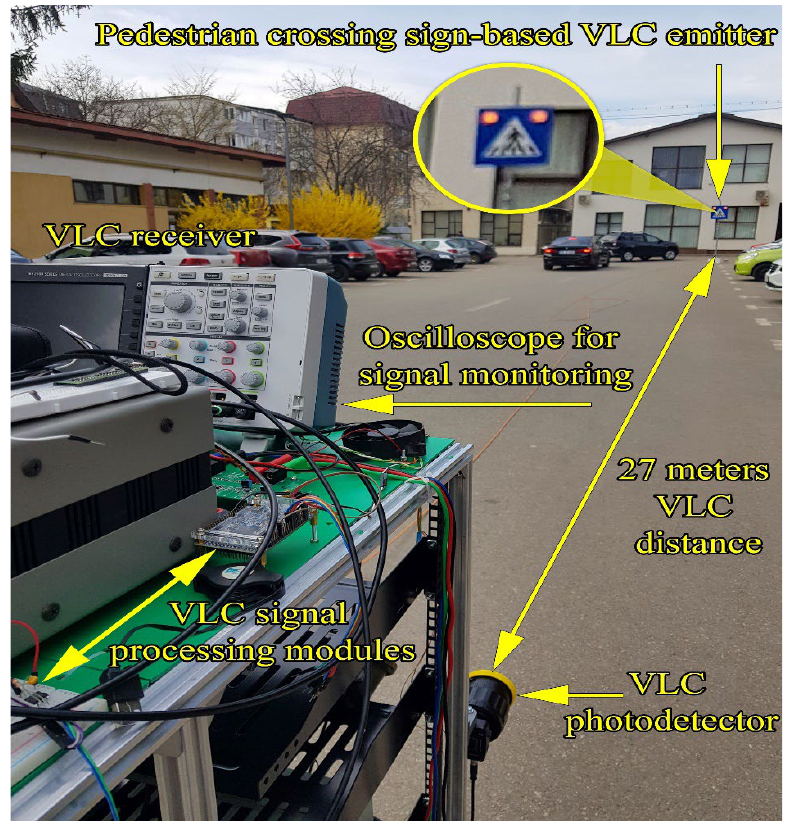
Figure 9. Visible light communications component outdoor experimental testing setup.